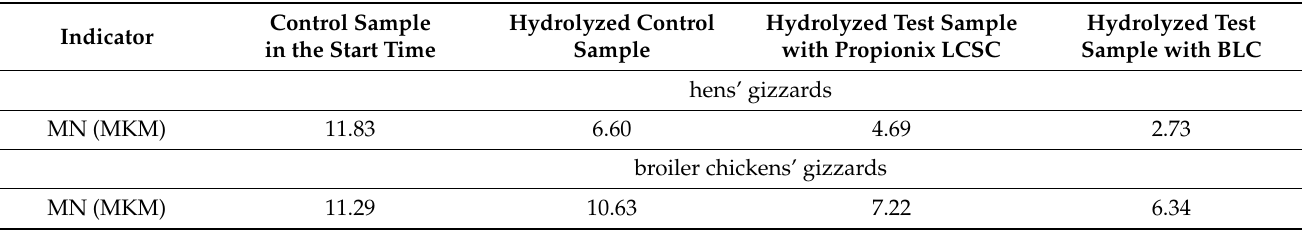
Table 5. Average hydrodynamic diameter determined from the numerical particle size distribution in hydrolysates. Control Indicator